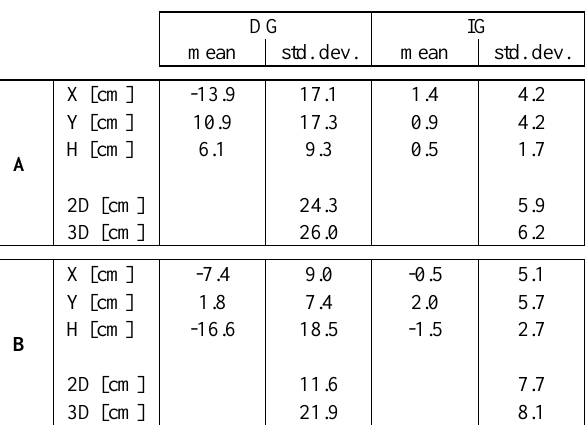
Figure 4: Urban canyon in test site A (top) and buildings and trees in test site B (down)